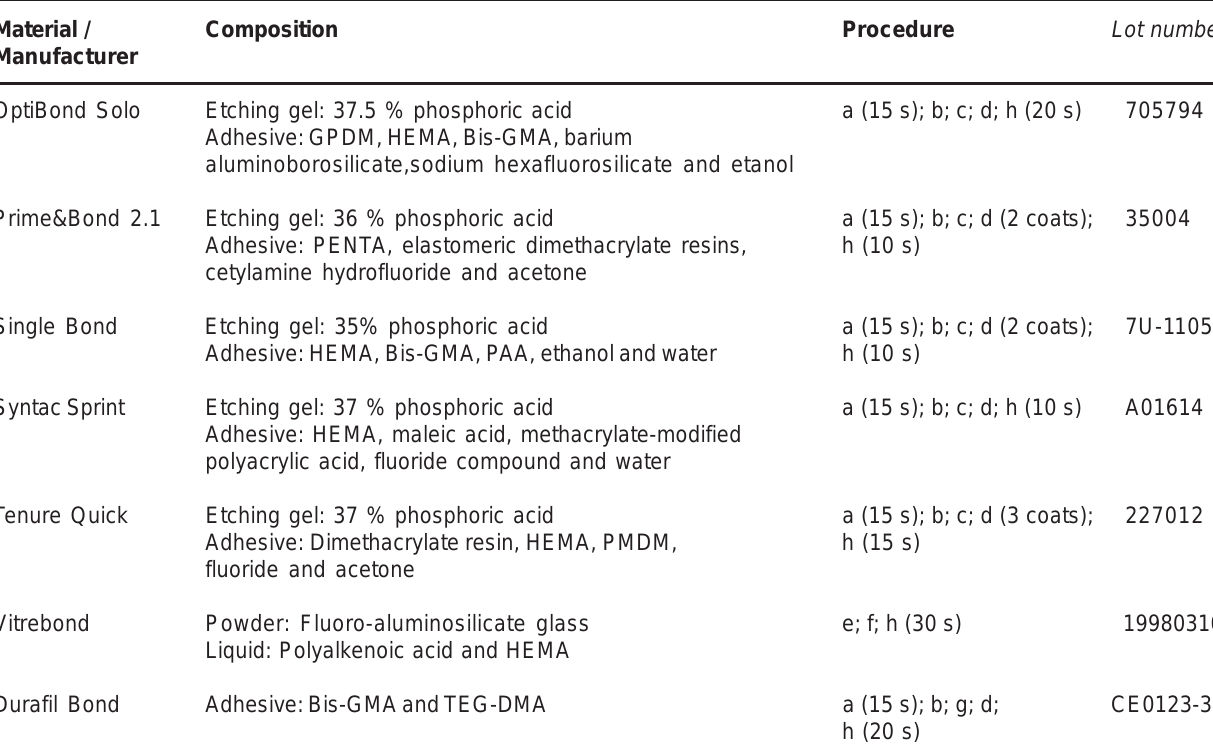
Procedures – a: acid etching; b: rinse; c: gently air; d: apply adhesive; e: mix powder + liquid; f: apply mixture; g: air dry; h: light